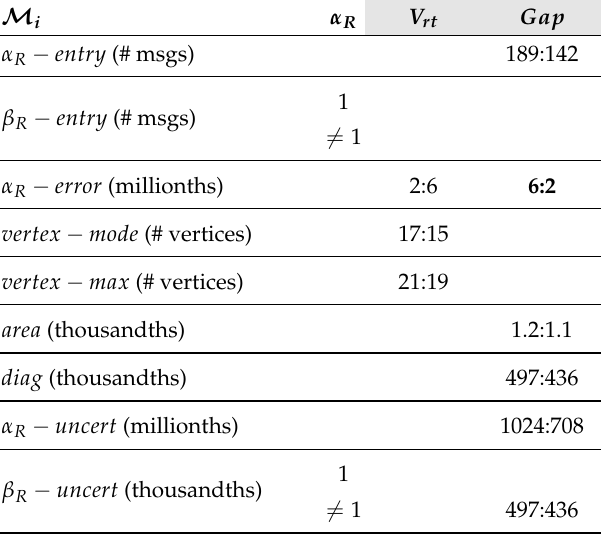
Table 5. Effects of the scenario on clock